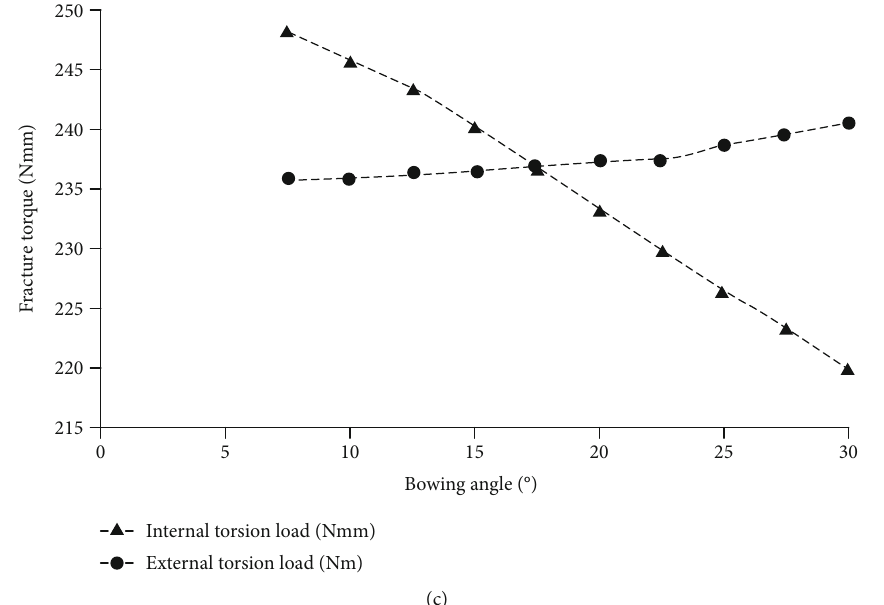
Figure 4: Fracture load as a function of the bowing angle for di ff erent load types: (a) fracture load in medial and lateral impacts; (b) fracture load in compression and tensile stresses; (c) fracture load in external and internal